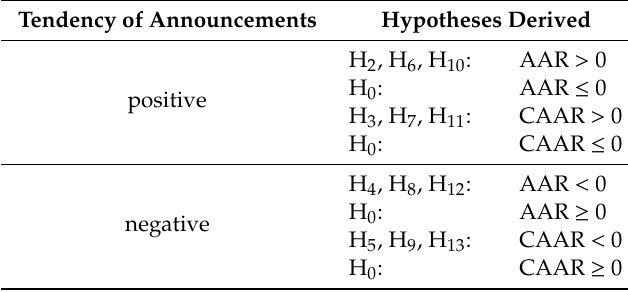
Table 4. Hypotheses derived from the literature review.